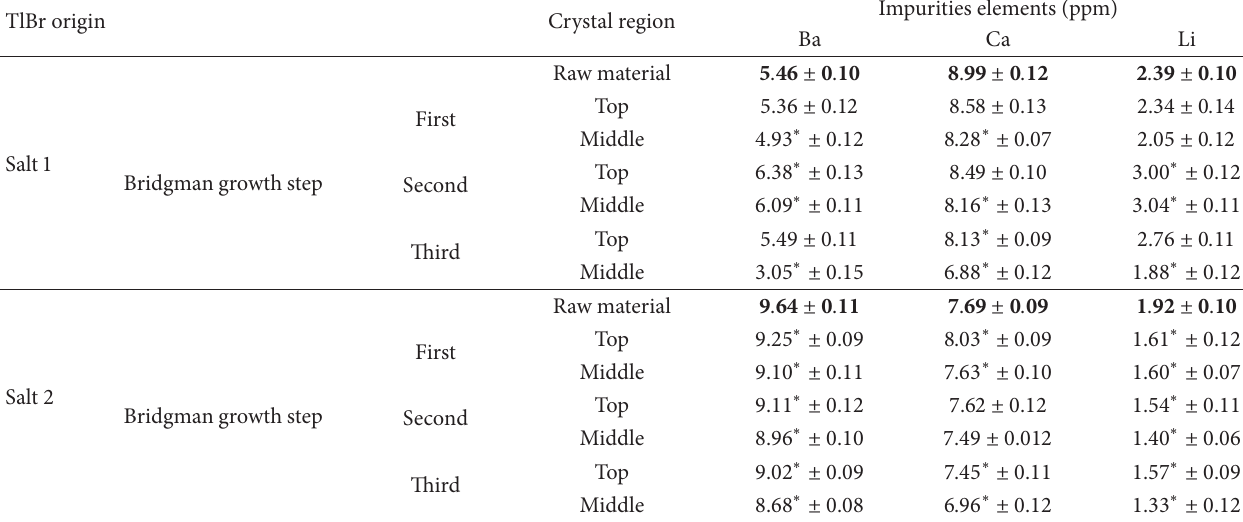
Table 1: Three impurity concentrations (ppm) in the TlBr salt and in the top and middle regions of the TlBr crystal, by ICP-MS. The values represent the mean one standard deviation ( 𝑁 = 10 samples).